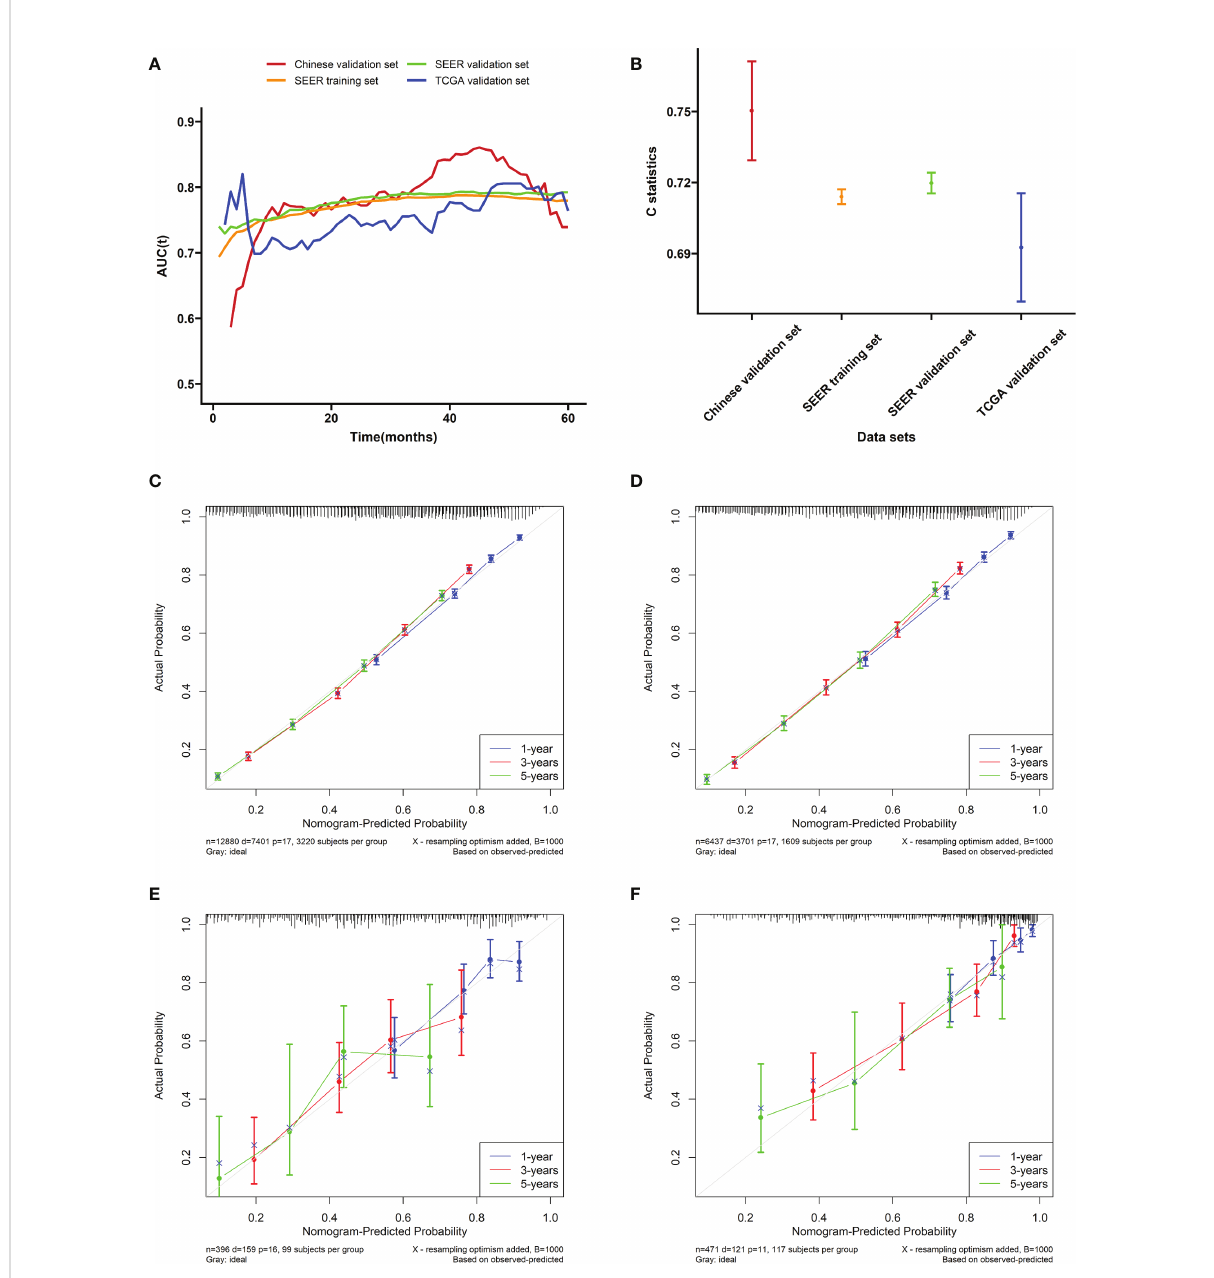
FIGURE 5 Evaluation of the nomogram. (A) The time-dependent AUC value of the nomogram in the training cohort (SEER), the internal validation cohort (SEER), the external validation cohort (TCGA), and the Chinese validation cohort. (B) The C-index of the nomogram in the training cohort (SEER), the internal validation cohort (SEER), the external validation cohort (TCGA), and the Chinese validation cohort. Calibration plots of the nomogram performed in the (C) SEER training, (D) the SEER internal validation, (E) the TCGA validation, and (F) the Chinese validation set,